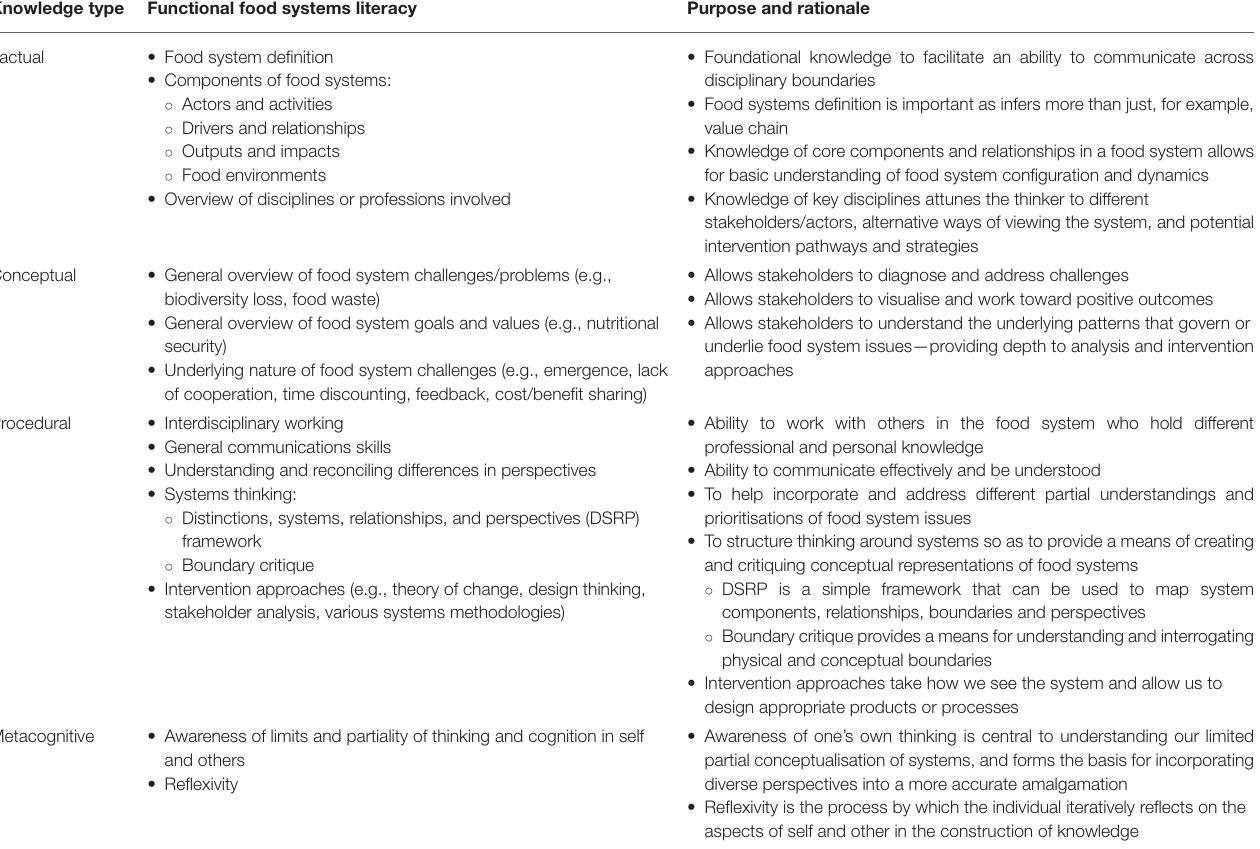
TABLE 2 | Overview of the proposed functional food systems literacy comprising four levels of knowledge. Knowledge type Functional food systems